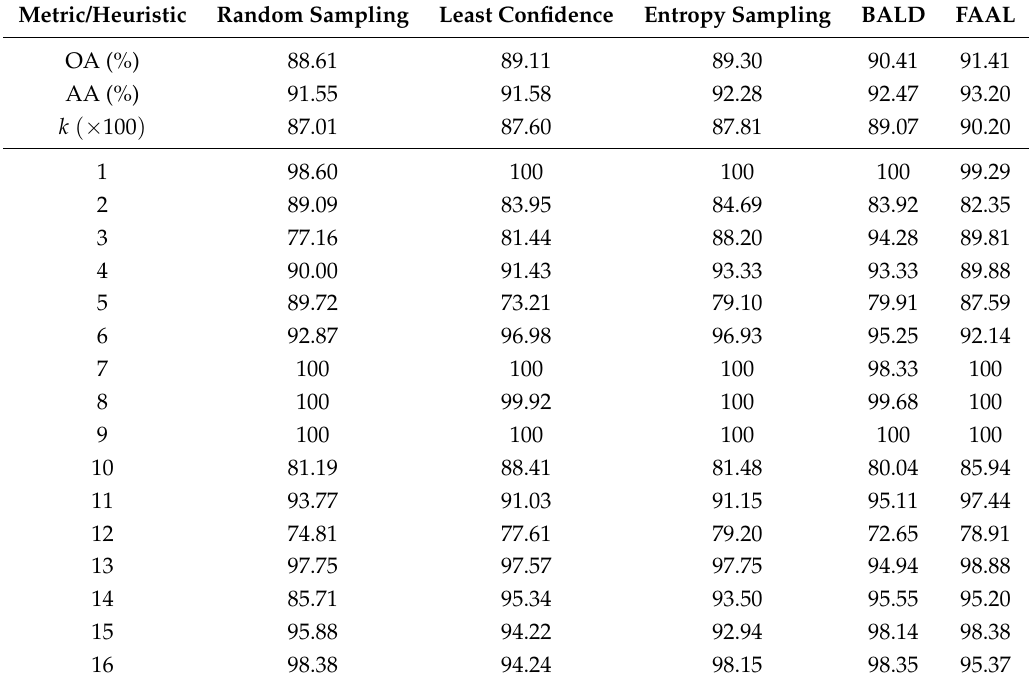
Table 7. Comparison of the classifier with different acquisition heuristics on Indian Pines. Metric/Heuristic Random